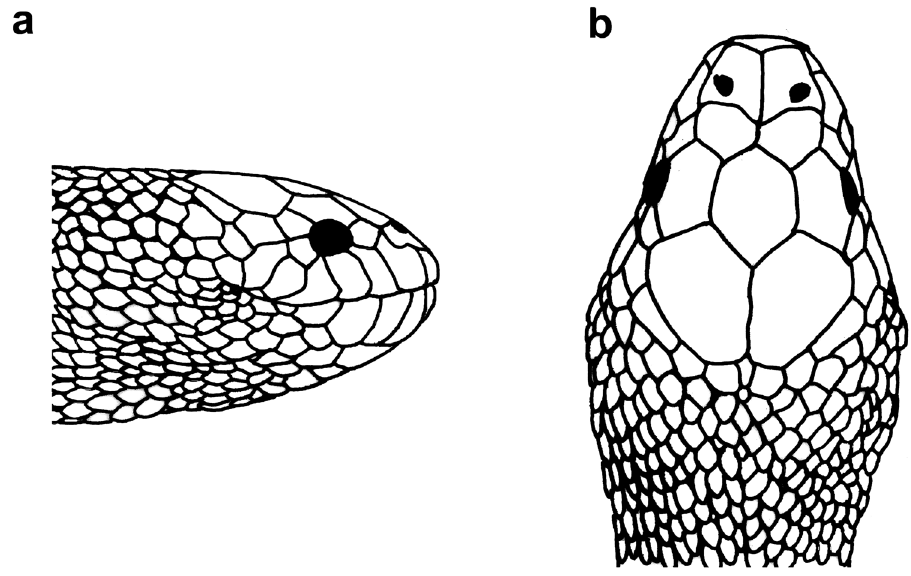
Figure 16. Head of Hydrophis ornatus : a lateral view b dorsal view.